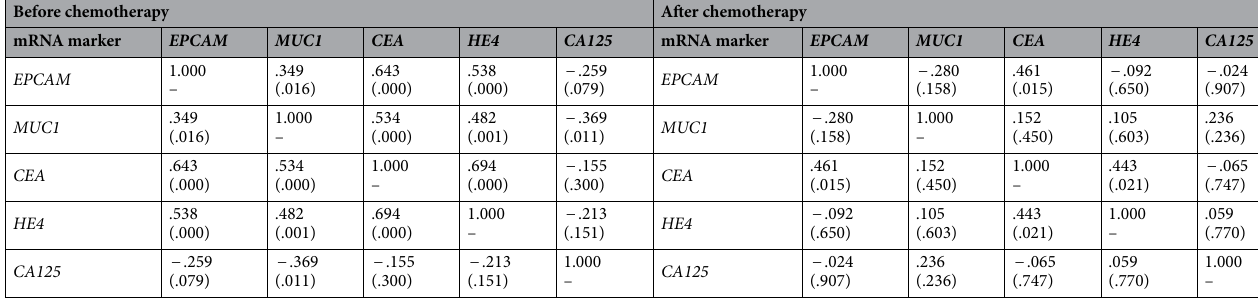
Table 4. The Spearman rank correlations between mRNA expressions of EPCAM , MUC1 , CEA , HE4 and CA125 markers in EOC patients before and after adjuvant chemotherapy. p values are in